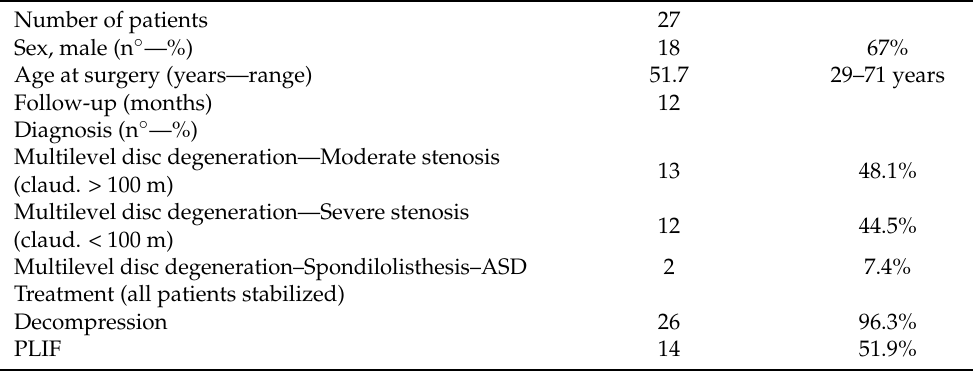
Table 1. Demographic data, diagnosis and associated procedures of the series ( n =